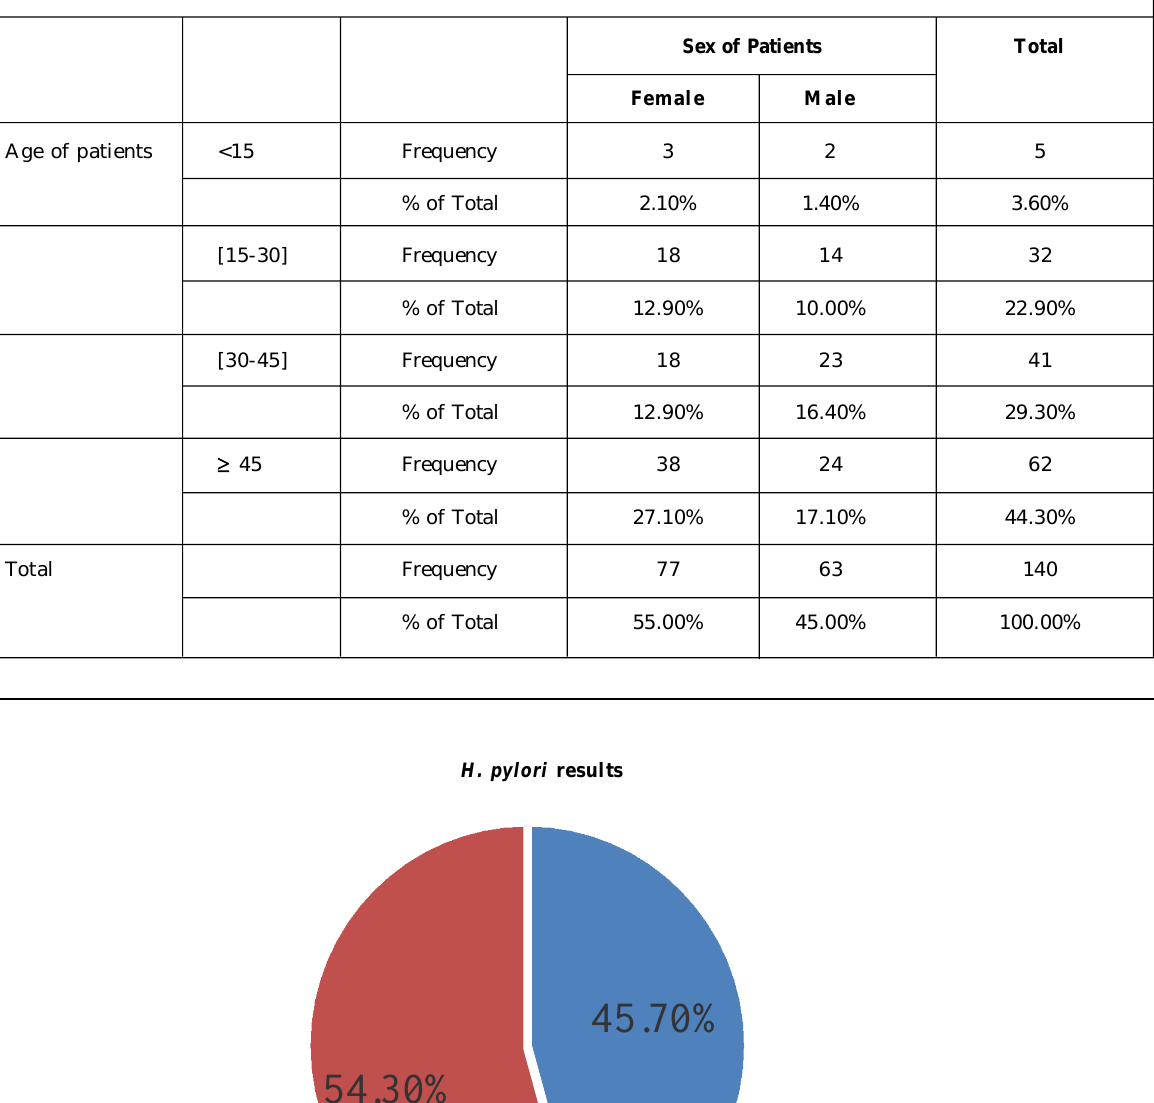
Sex of Patients Total Female Male